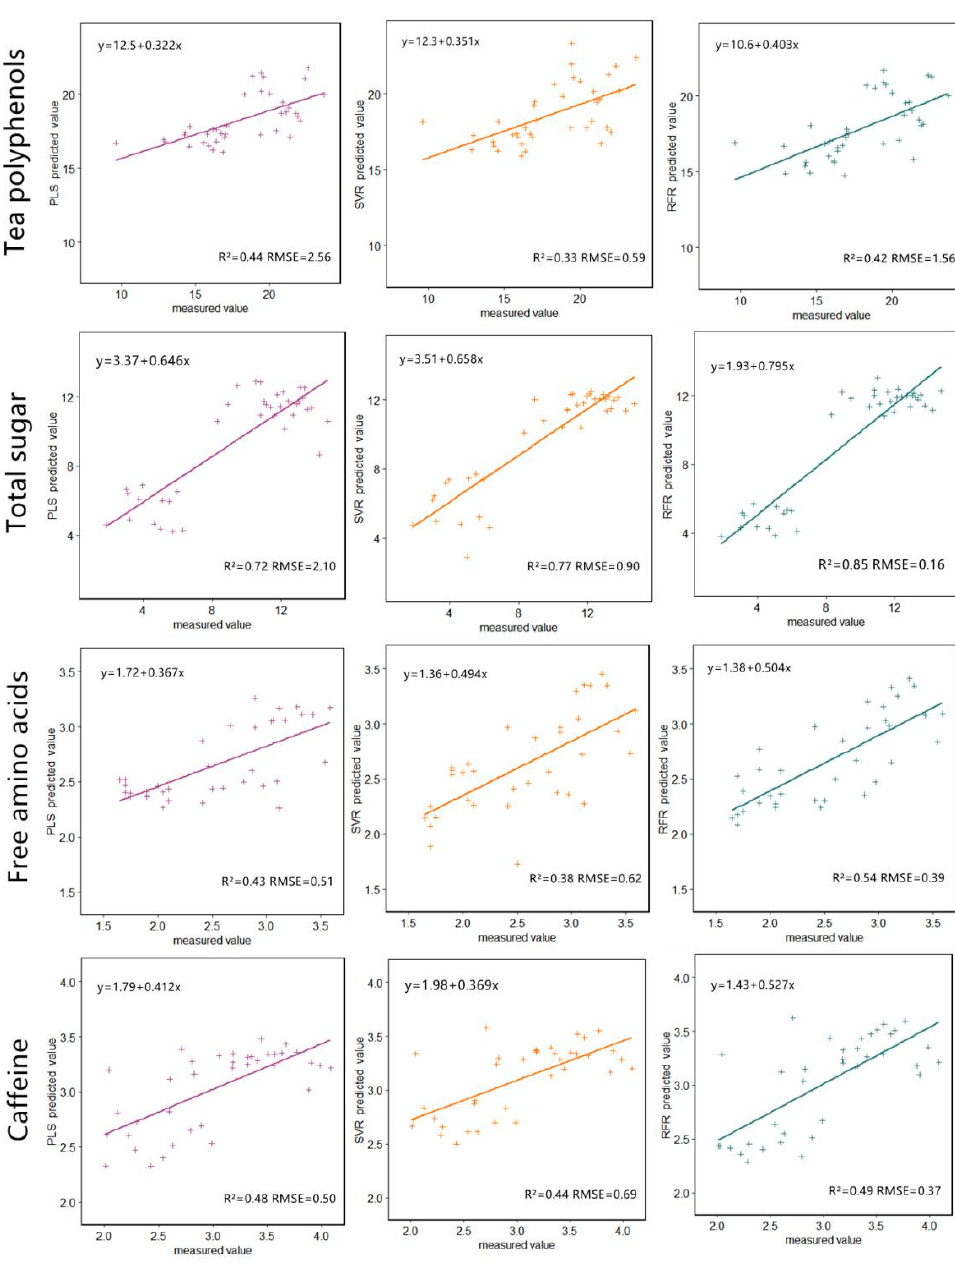
Figure 10. Results of different regression methods for tea polyphenols, total sugar, free amino acids, and caffeine.